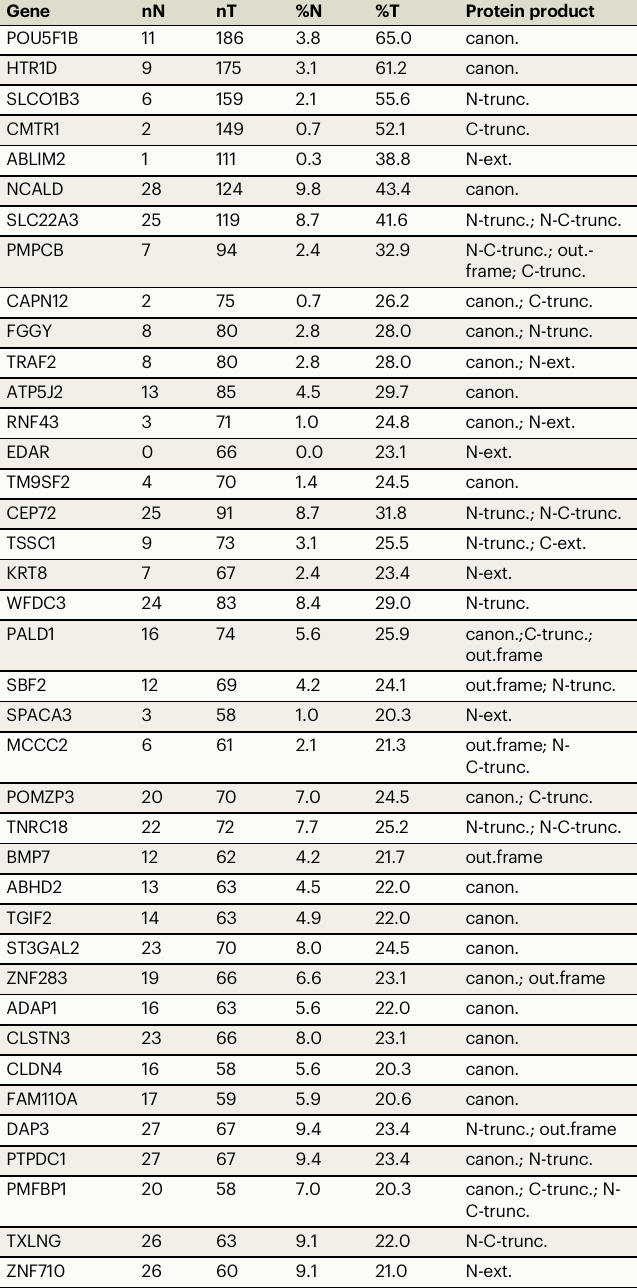
Table 1 | Thirty-nine TcGT-transcribed genes were detected in more than 20% of CRC tumors and less than 10% of normal colons